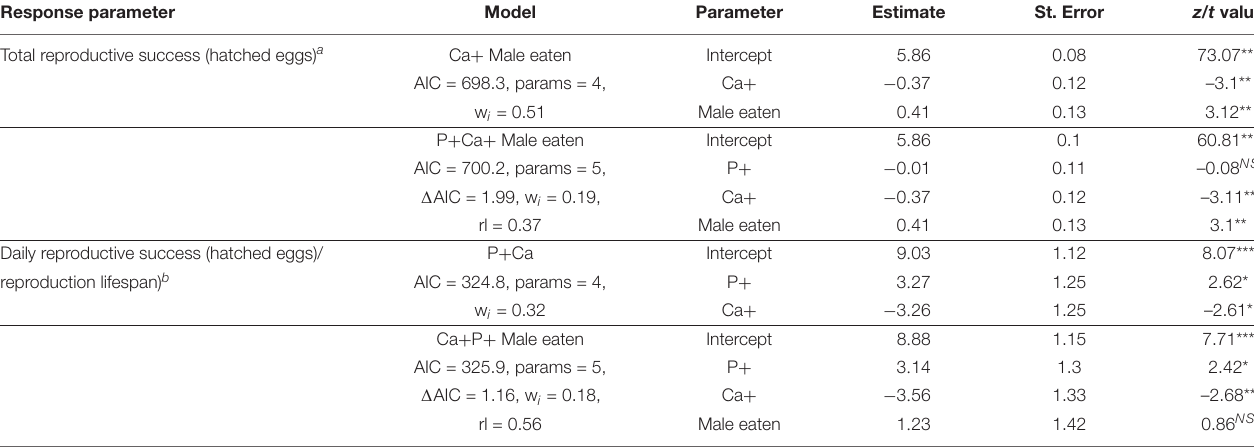
TABLE 1 | Model summaries for treatment effects on reproductive success parameters. Response parameter Model Parameter Estimate